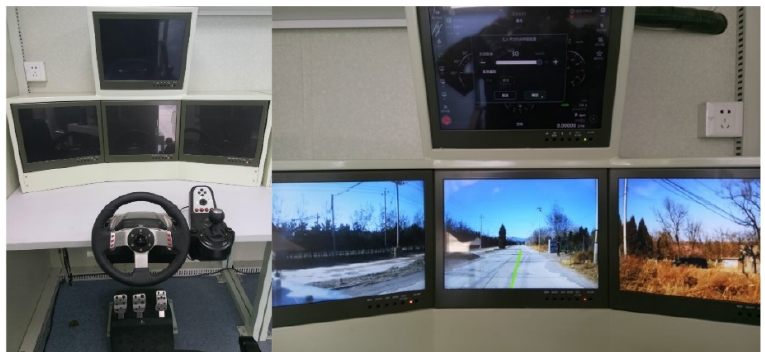
Figure 24. Teleoperation system.